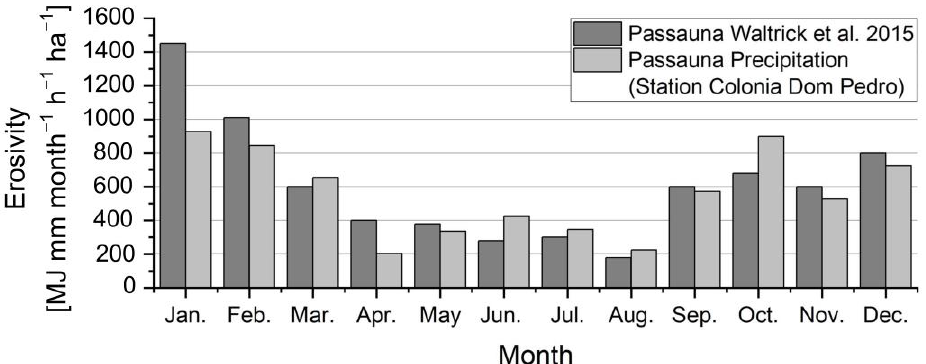
Figure 13. R Factor from two Figure 12. R Factor from two approaches.